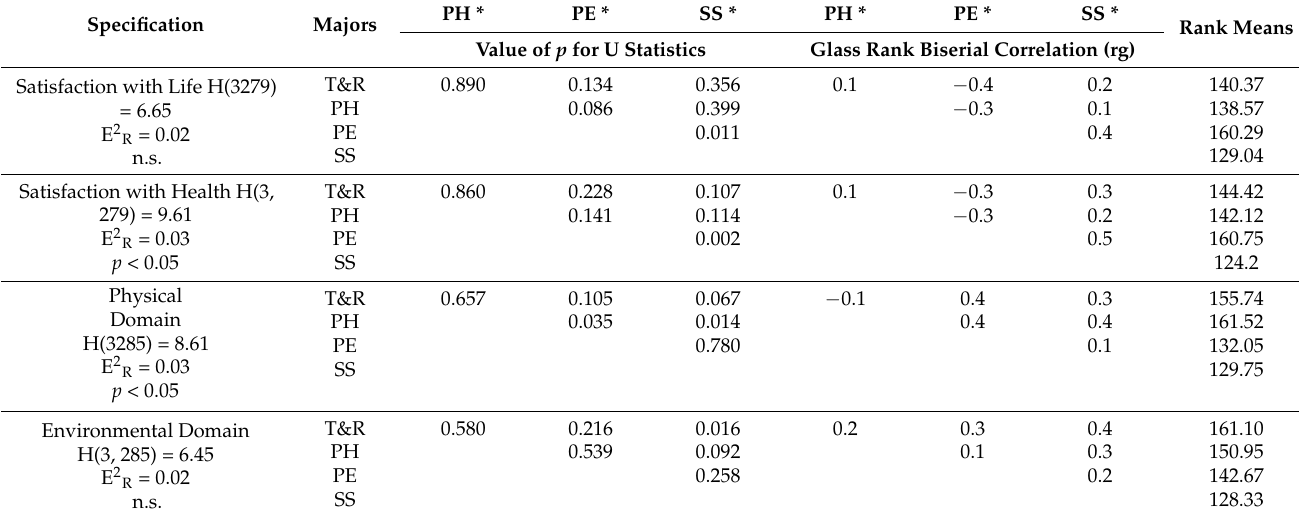
Environmental Domain H(3, 285) = 6.45 E 2 R = 0.02 n.s.